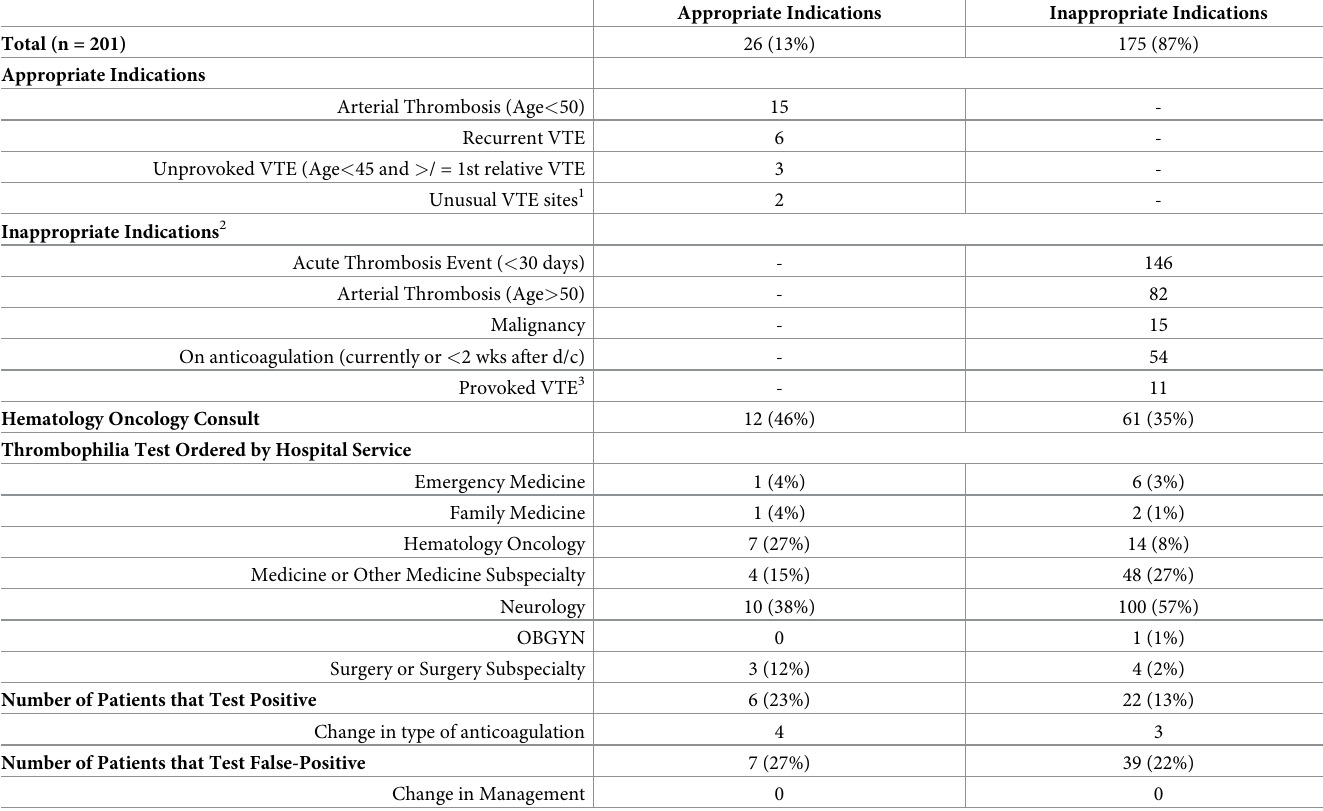
Table 2. Thrombophilia testing indications and